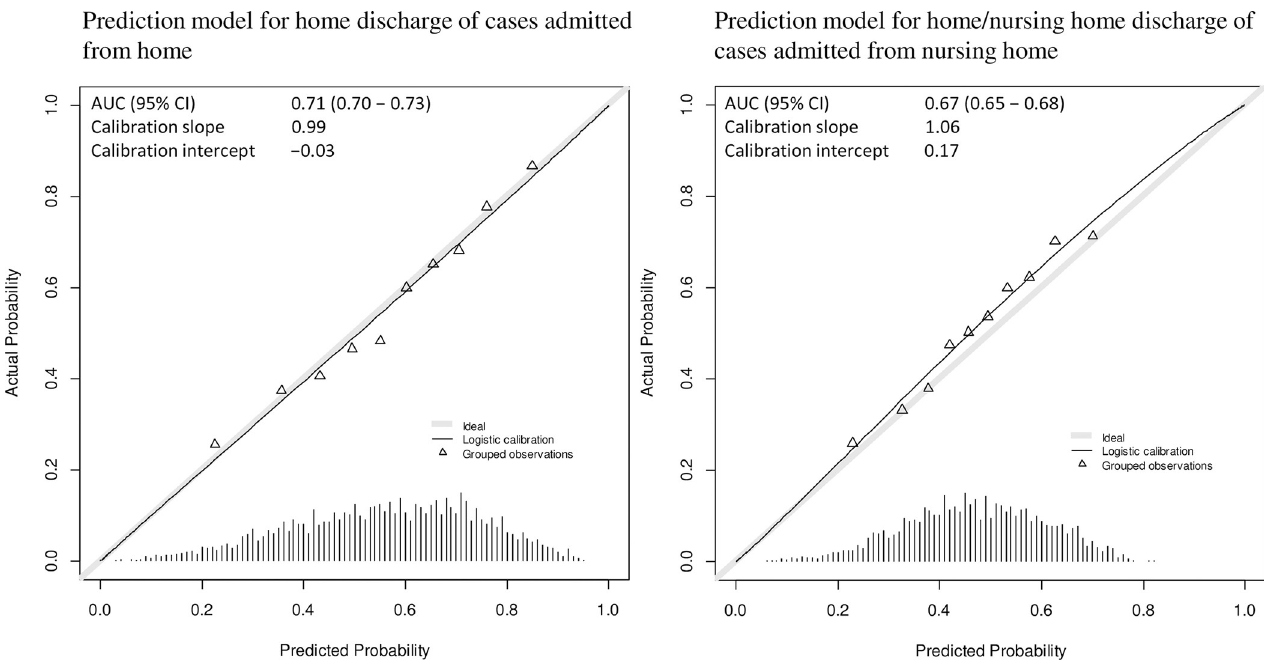
Fig 3. Results of internal-external validation with calibration plots of the two models. AUC, area under curve; 95% CI, confidence interval.